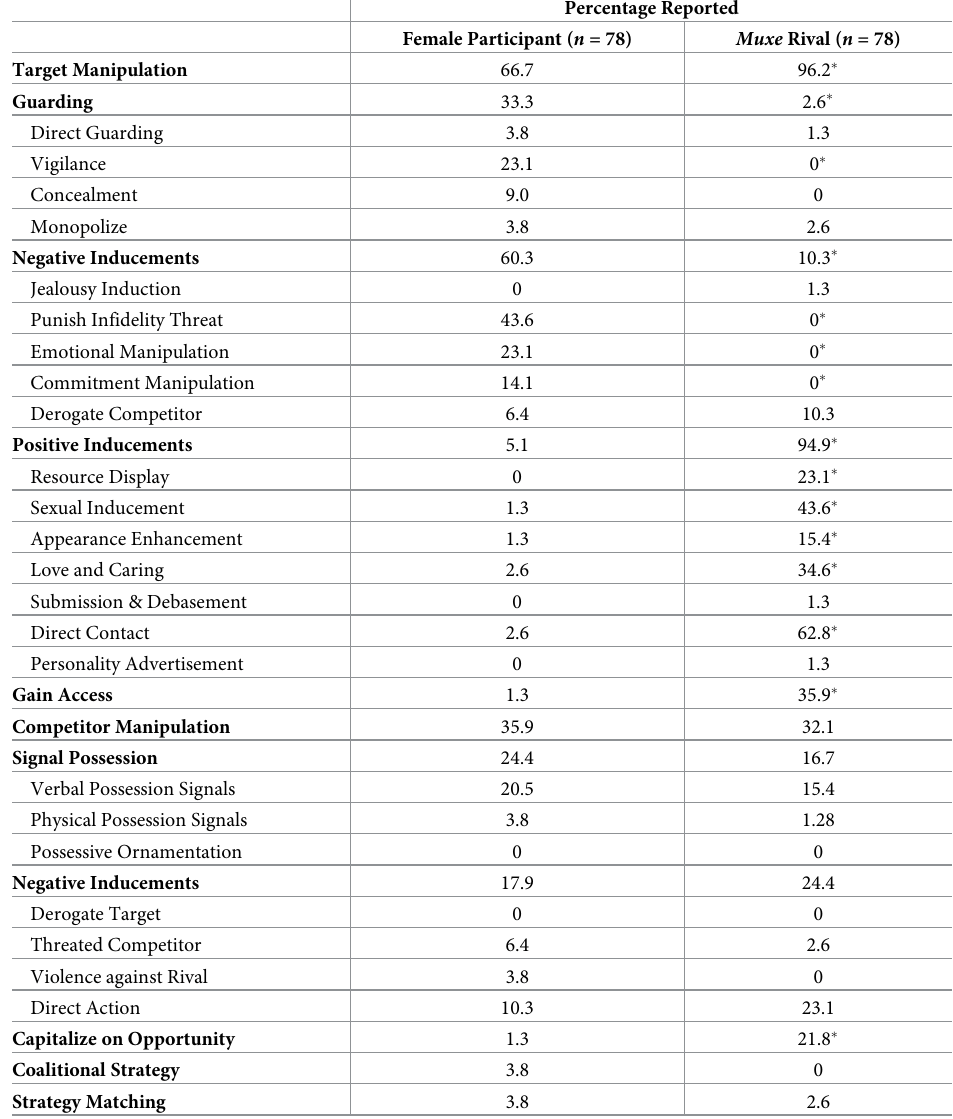
Table 4. Inter-sexual mate competition retention/poaching tactics in the Istmo